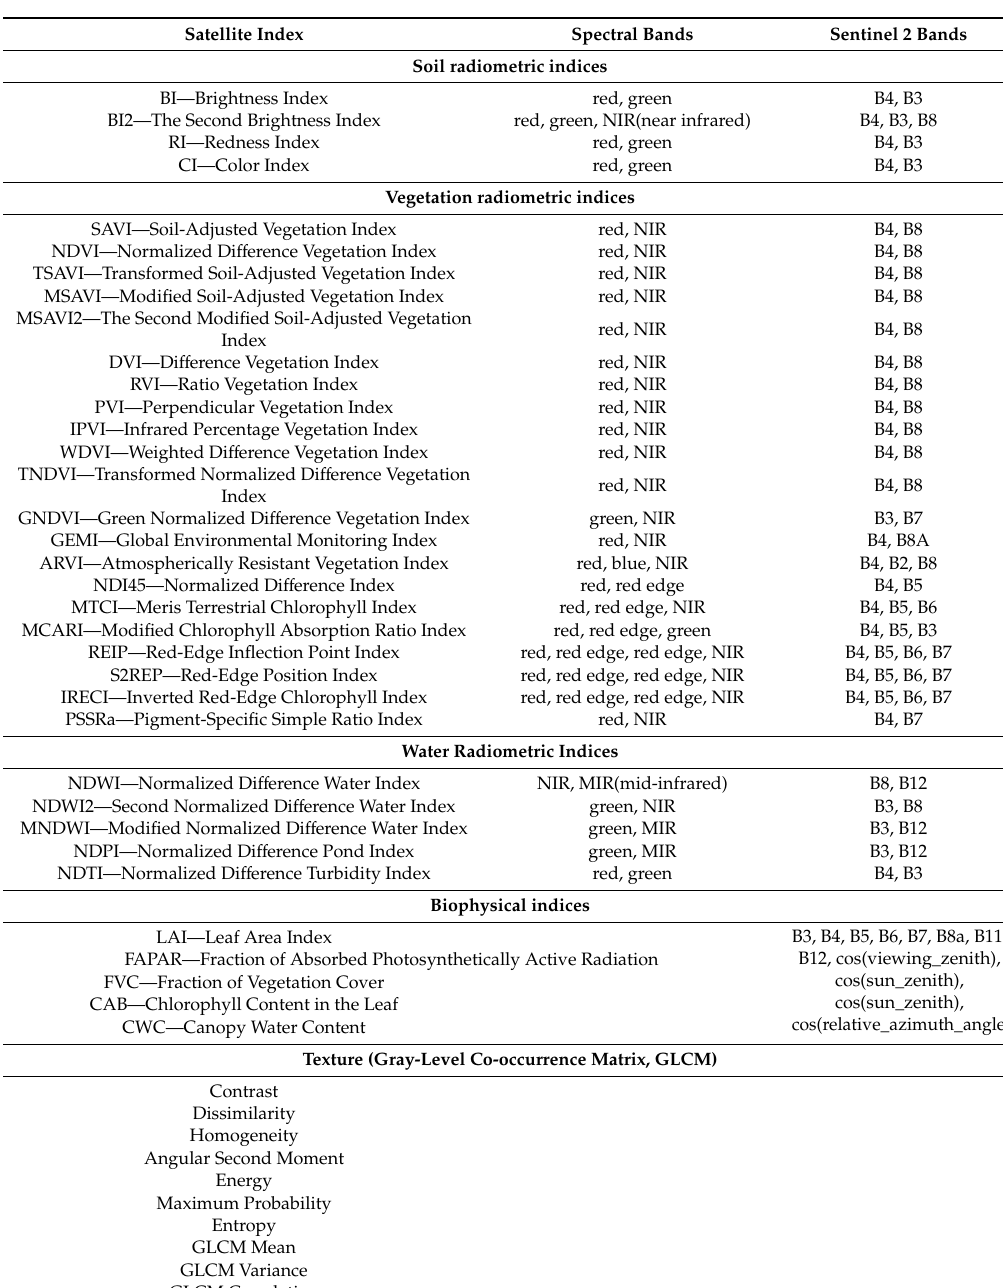
Table 2. Derived satellite indices and textural